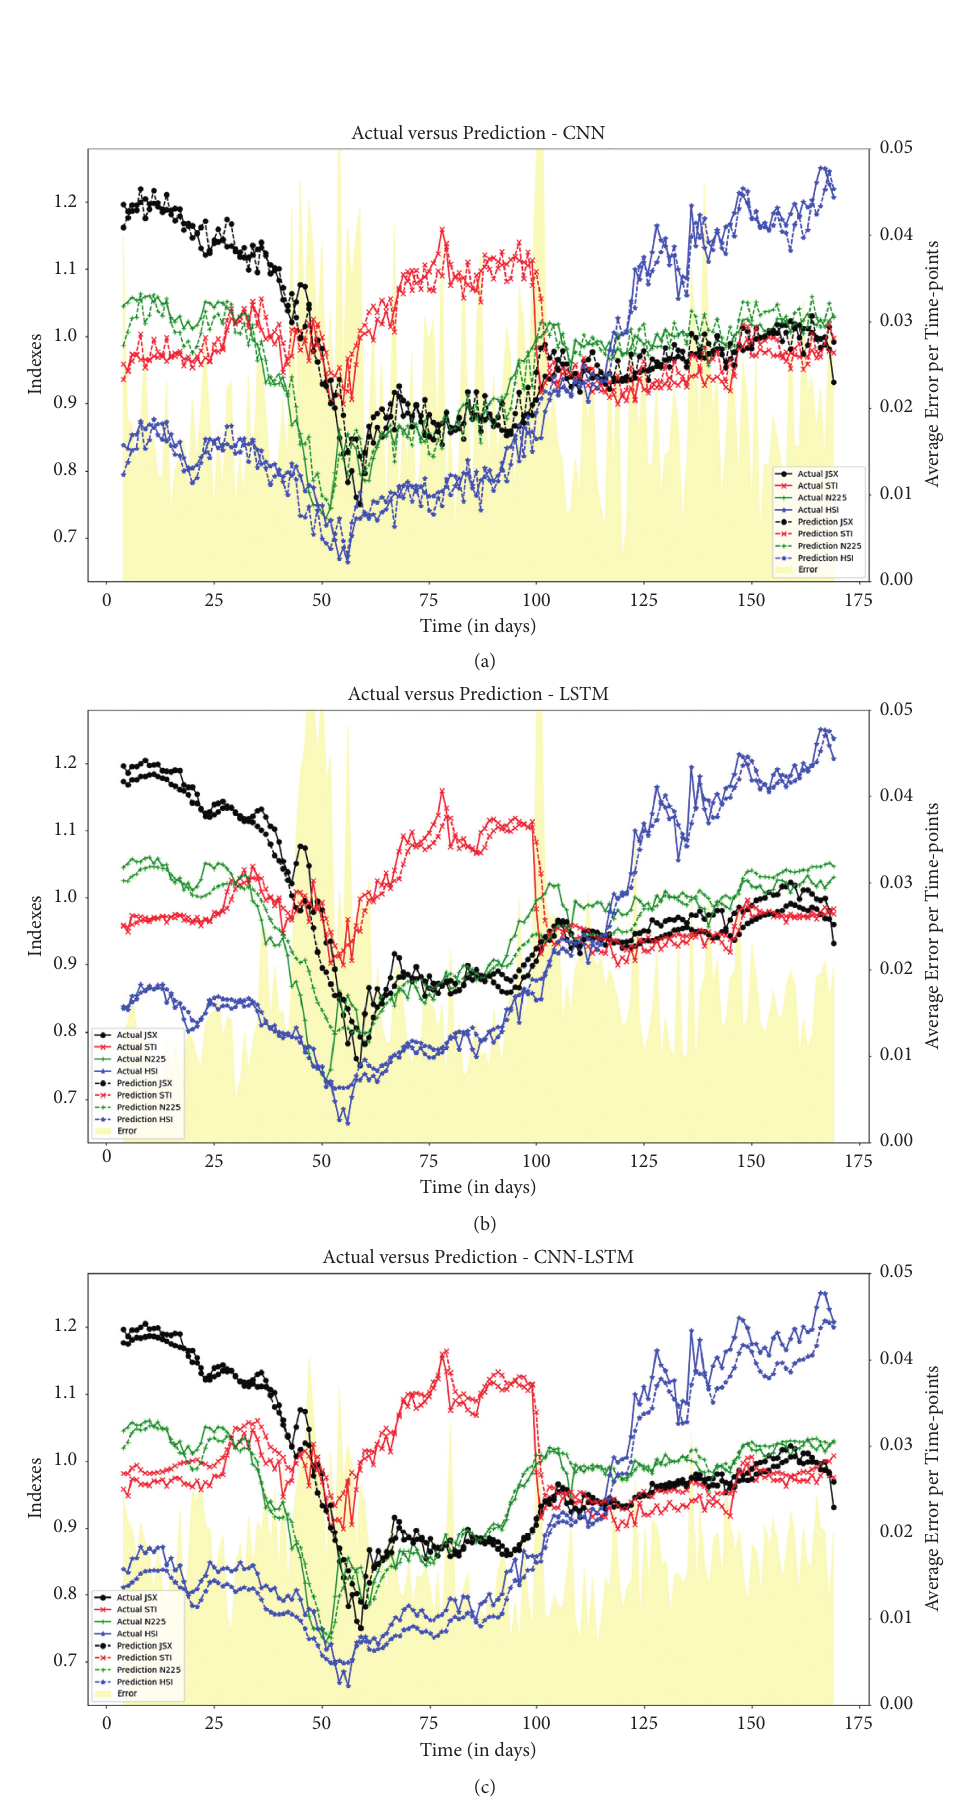
Figure 5: Comparison of the actual (solid line) and predicted values (dashed line) in the training phase (first 170 trading days of the year 2020): (a) by CNN Model, (b) by LSTM model, and (c) by the ensemble of